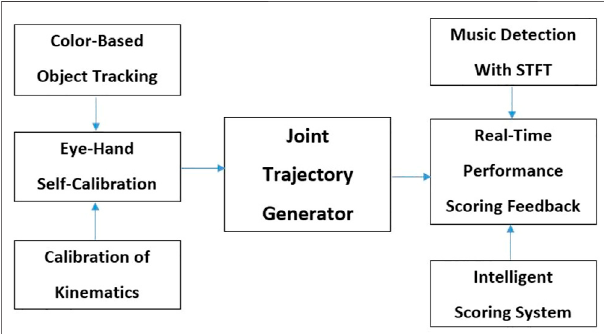
Figure 5 shows the above-described procedure